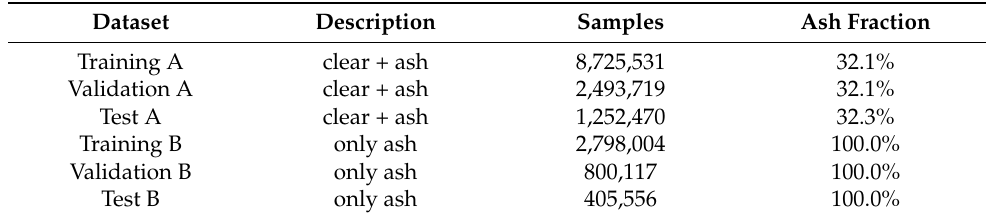
Table 1. Information on the different simulated